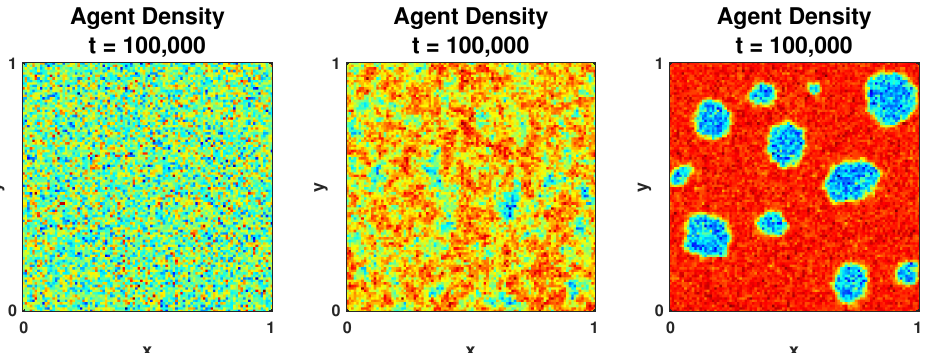
Figure 16. Agent density lattices for the first variation (Timidity Model) taken after 100,000 time = 1, and N = N = 75,000 agents. On all lattices, the first β value is steps for δ t = 1, L = 100, γ 2 1 λ fixed to β 1 = 5 × 10 − 6 . Starting from the top left, the second β value used was 1 × 10 − 6 ,1 × 10 − 5 and 2 × 10 − 5 , respectively. The color of gang 1 is red, while gang 2’s color is blue. In the first lattice, β 1 β 2 < β ∗ , and this resulted in the agents being well-mixed. In the second and third lattice, β 1 β 2 > β ∗ , and this resulted in the agents